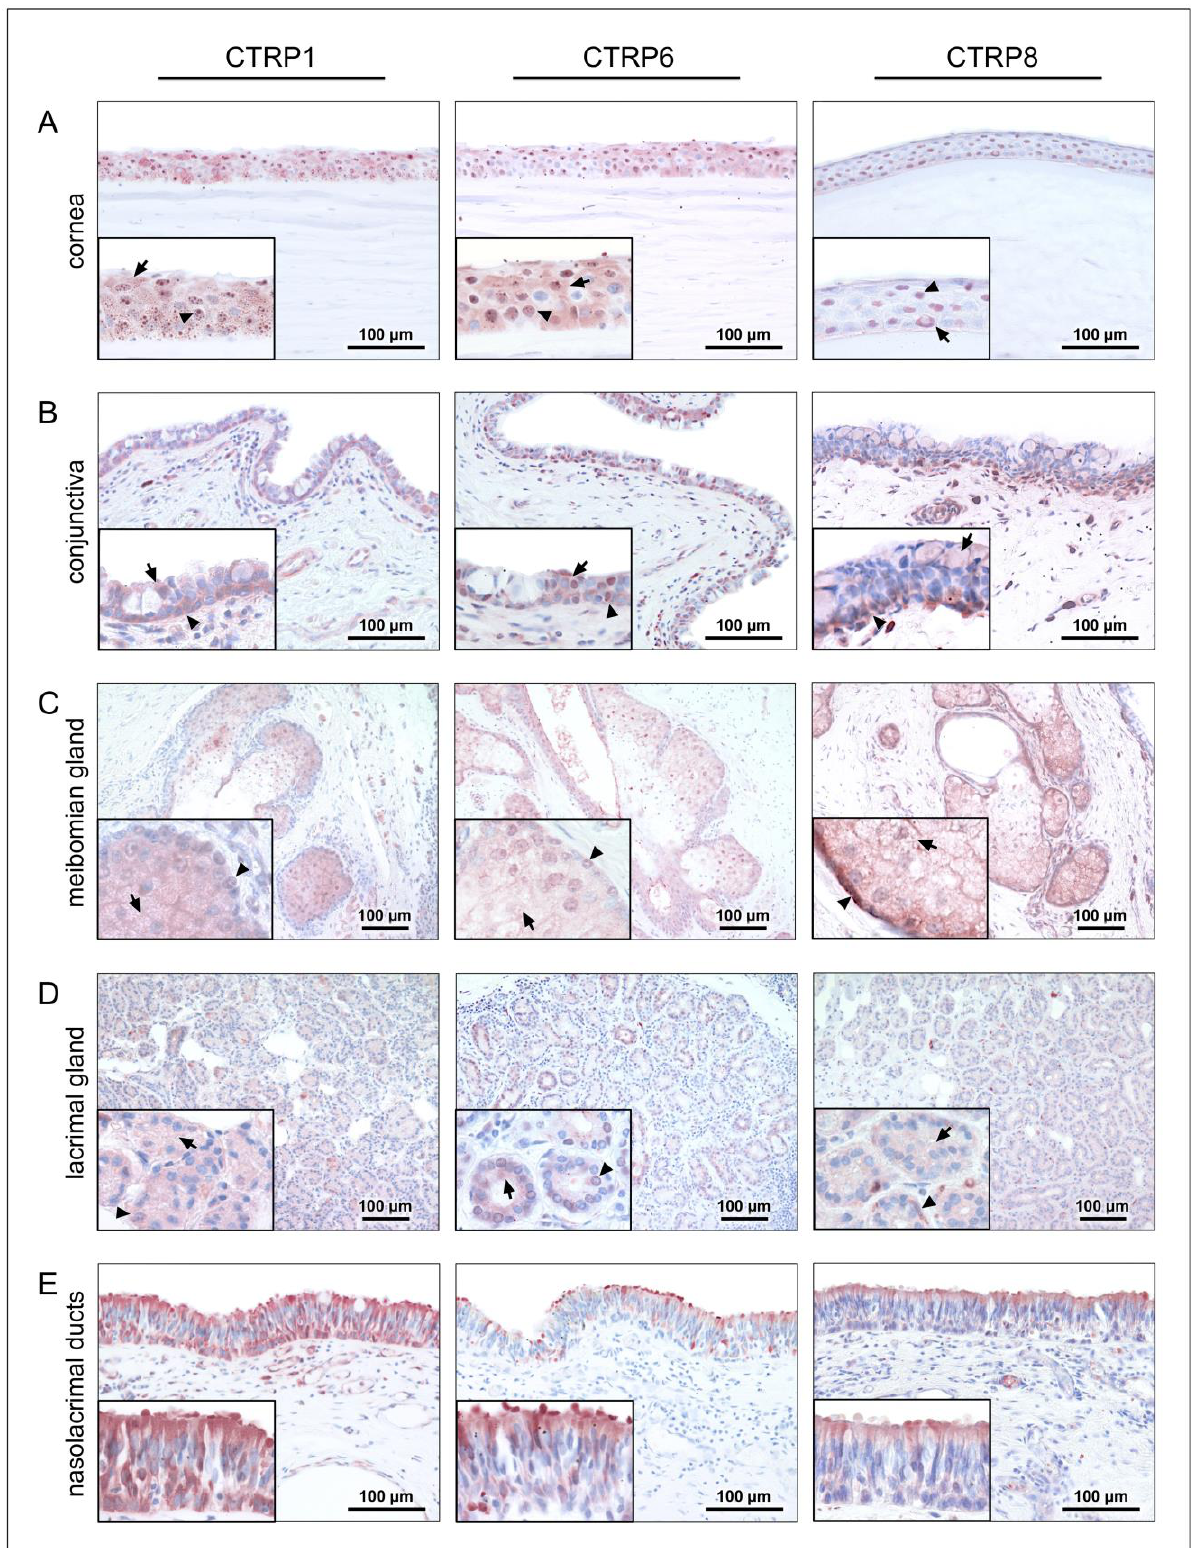
Figure 2. Immunohistochemical detection of CTRP1, CTRP6, and CTRP8 in tissues of the human lacrimal apparatus and ocular surface. The antibody reaction can be seen by the intracellular red reactivity. Pictures shown are representative for human cornea ( A ), conjunctiva ( B ), meibomian gland of upper eye lid ( C ), lacrimal glands ( D ), and nasolacrimal ducts ( E ). Inlays show higher